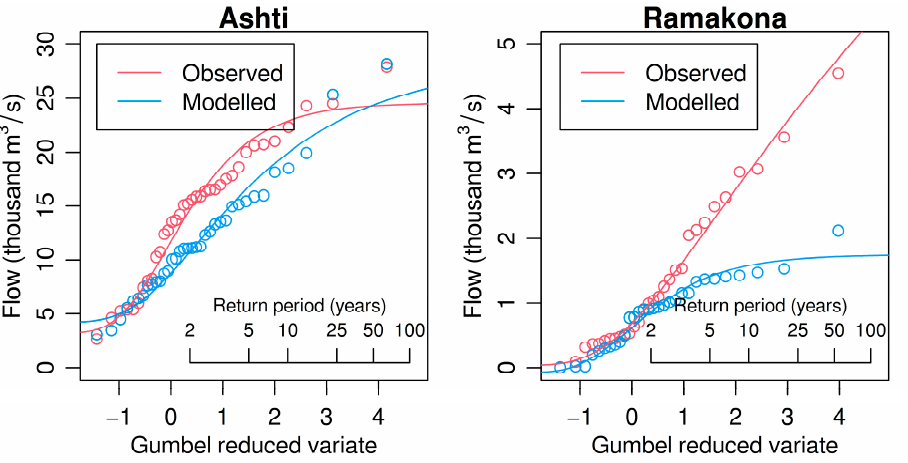
Figure 7. Observed and modeled flood frequency curves for Ashti and Ramakona.